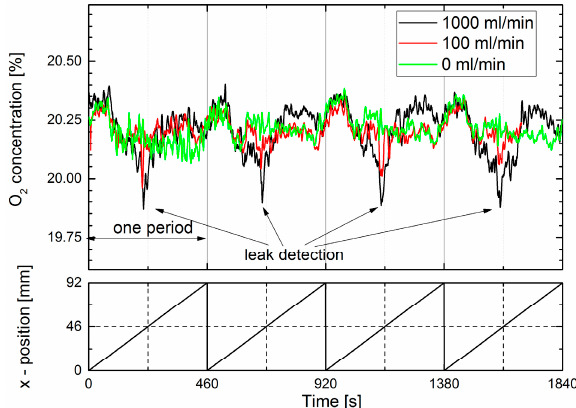
Figure 9. Standoff dynamic N 2 leak detection via measurement of the O 2 concentration. The distance between the laser and leak plate was 55 cm. The leak plate was horizontally moved by a sliding stage with a speed of 0.2 mm/s in a sawtooth manner, as indicated by the lower figure. The leak position is at 46 mm.